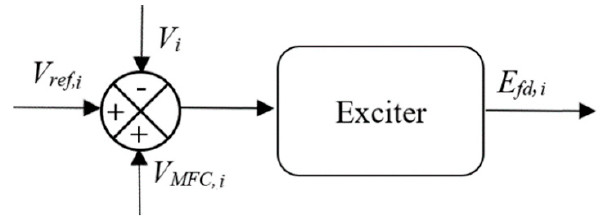
Figure 5. Addition of the model-free control (MFC) output signal to the excitation system of a synchronous generator (SG)-based Distributed Energy Resource (DER).